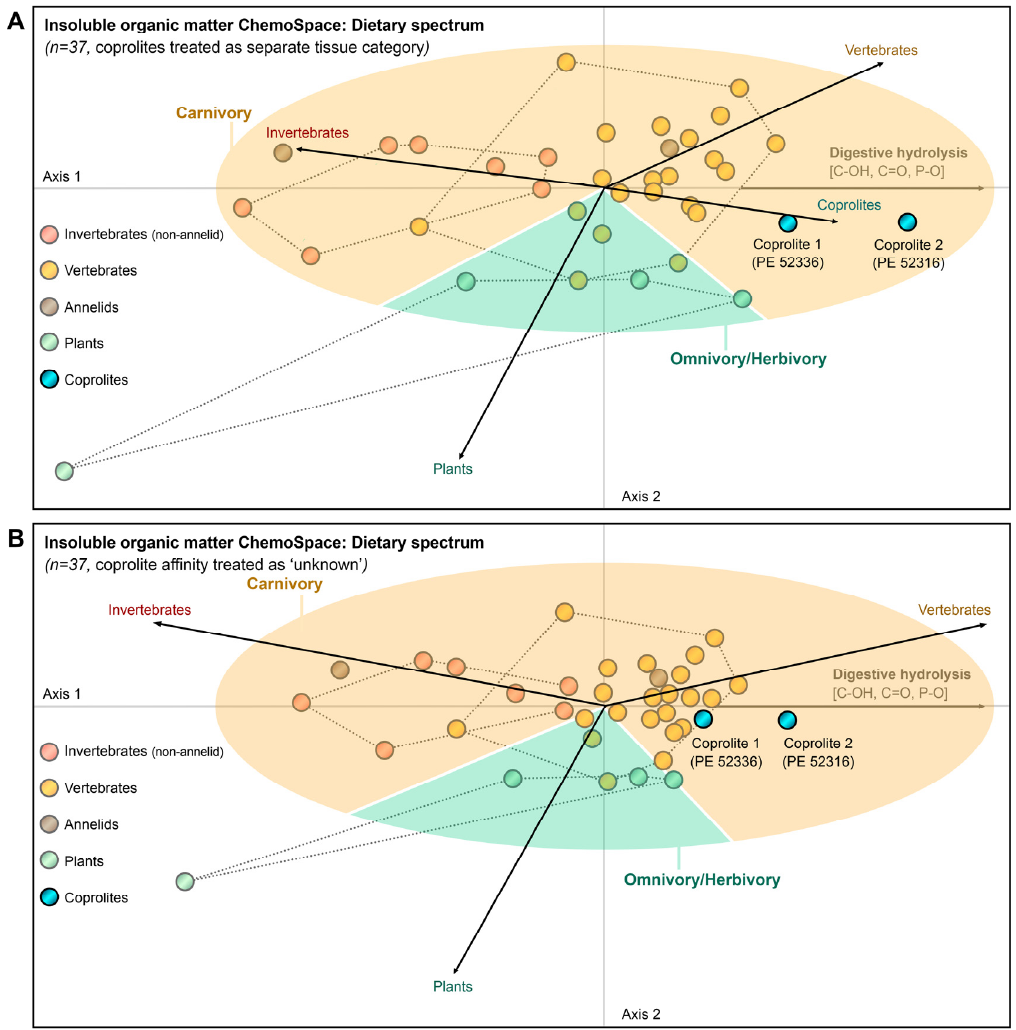
Figure 4. Dietary ChemoSpace analysis of tissue type signals preserved in carbonaceous coprolites from the Mazon Creek locality. A total of n = 37 Mazon Creek carbonaceous fossils and coprolites were spectroscopically fingerprinted ( n = 1 biological replicate and n = 10 mean-averaged technical replicates per data point), identified, and analysed by means of a Canonical Correspondence Analysis (CCA; discriminant analysis). ( A ) ChemoSpace resulting from a CCA that treated coprolites as a separate tissue category (black arrows); corresponding trajectories of functional groups in the ChemoSpace are plotted in Figure 5B. ( B ) ChemoSpace resulting from a CCA that treated the tissue affinity of coprolites as unknown; corresponding trajectories of functional groups in the ChemoSpace are plotted in Figure 5C. ChemoSpaces in both, ( A ) (clustered in n = 5 categories, each contained in a dotted, convex hull; except from annelids and coprolites due to small sample size) and ( B ) (clustered in n = 4 categories, each contained in a dotted, convex hull, except from annelids), reveal that fossil coprolites are compositionally distinct from undigested fossil soft tissues due to digestive hydrolysis of macromolecules prior to fossilisation (detailed differences are plotted in Figure 5B), and contain predominantly digested tissues of vertebrate prey items. Thus, carnivory (orange circle fraction, contrary to omnivory/herbivory = green circle fraction) can be inferred for both coprolite producers. Source Data are available for the CCAs in ( A , B ).